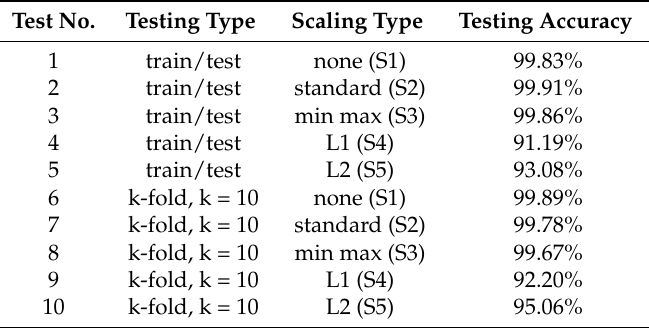
Table 9. Classification accuracy for M3 SVM OVR on BUZZ1 train/test dataset.